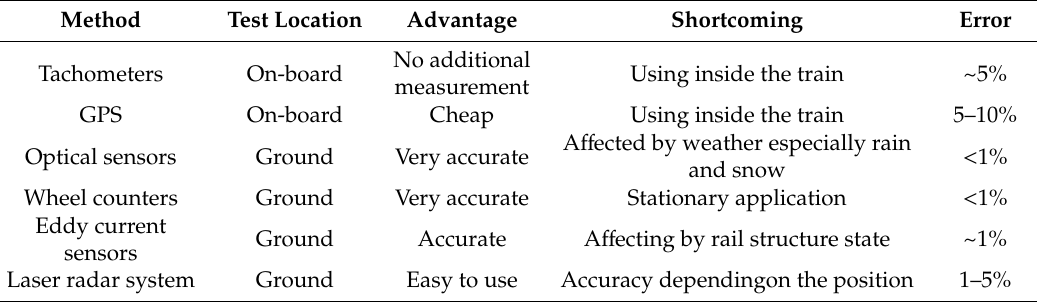
Table 1. Existing methods for train speed